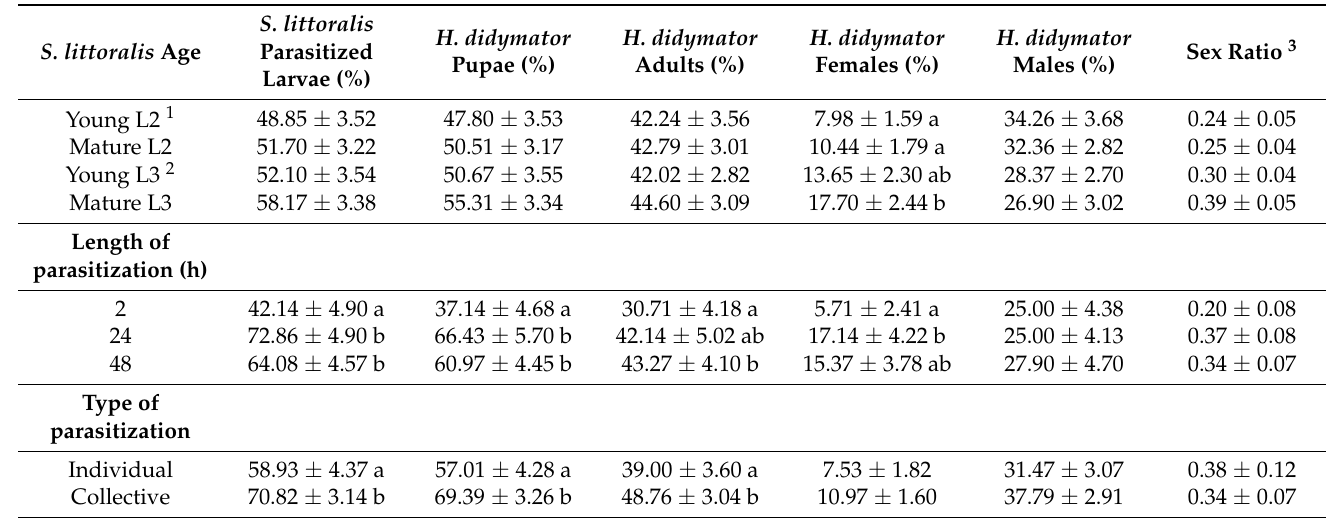
Table 1. Influence of Spodoptera littoralis host larvae age, length of parasitization, and type of parasitization on Hyposoter didymator developmental and reproductive parameters, in relation to the number of host larvae offered to the parasitoid. Sex ratio of the offspring refers to the number of females in relation to the number of adults). Lowercase letters stand for significant